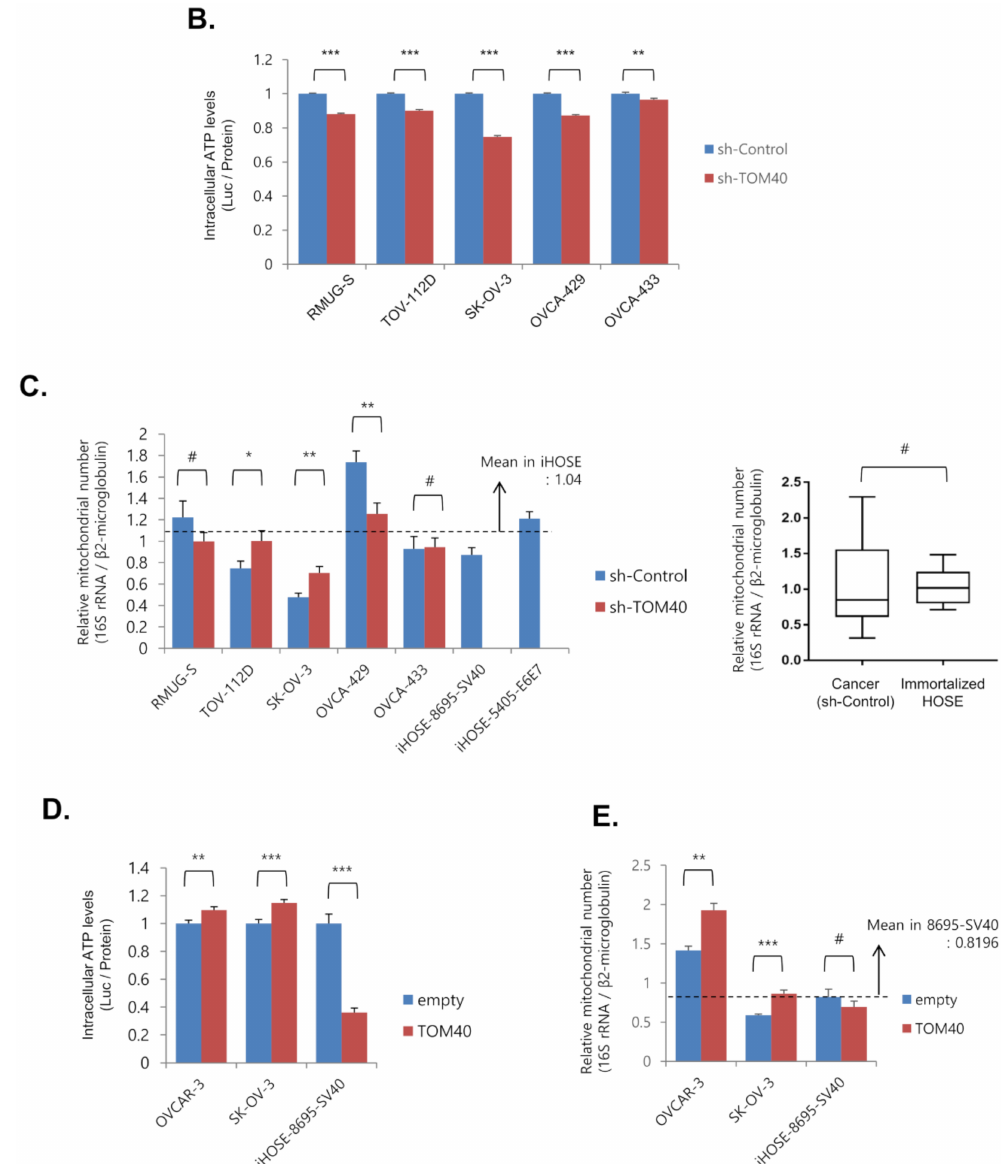
Figure 3. TOM40 expression is positively correlated with intracellular ATP levels. ( A ) Intracellular ATP levels were measured with a luciferase activity assay in whole cell lysates from epithelial ovarian cancer (EOC) cell lines and immortalized HOSEs (iHOSE). Luciferase activity (ATP levels) is expressed as a ratio of luciferase levels to protein quantity (bar graph, left). Results represent the means ± Standard Error (S.E.)., n = 4. Box plot (right) represents the comparative intracellular ATP levels of EOC cells compared to iHOSE cells. (Cancer, n = 14; iHOSE, n = 2). ( B , D ) Intracellular ATP levels were measured with an ATP assay kit based on luciferase activity. The relative intracellular ATP levels were quantified as a ratio of luciferase levels to protein quantity. Results are the mean ± S.E. (B, n = 12; D , cancer cell, n = 20; iHOSE, n = 8; ** p < 0.01 and *** p < 0001). ( C , E ) Cellular mitochondrial levels were measured by real-time PCR using total cellular DNA samples. The relative mitochondrial number was quantified as a ratio of mitochondrial 16S rRNA / ß2-microglobulin levels. Fold induction was calculated as a relative expression by iHOSE-empty vector cells. Results represent the mean ± S.E. (C, n = 9; E, n = 5; # p > 0.05, * p < 0.05, ** p < 0.01, and *** p < 0.001). Box plot in Figure 3C represents the relative mitochondrial number of sh-control EOC cells compared to sh-control iHOSE cells (cancer, n = 5; iHOSE, n =